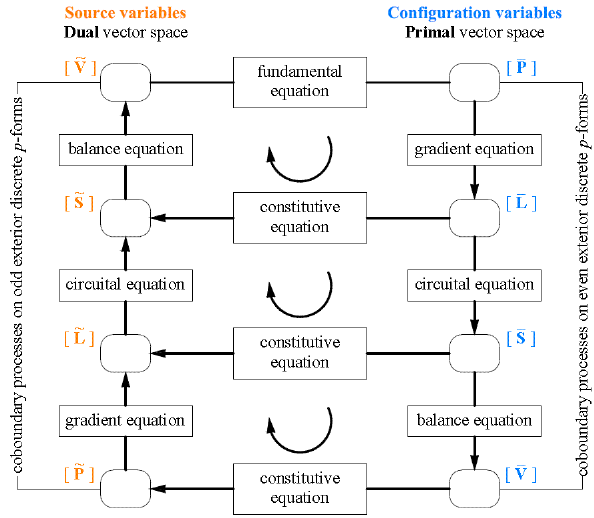
Figure 7: Classification diagram of the physical variables in the fundamental